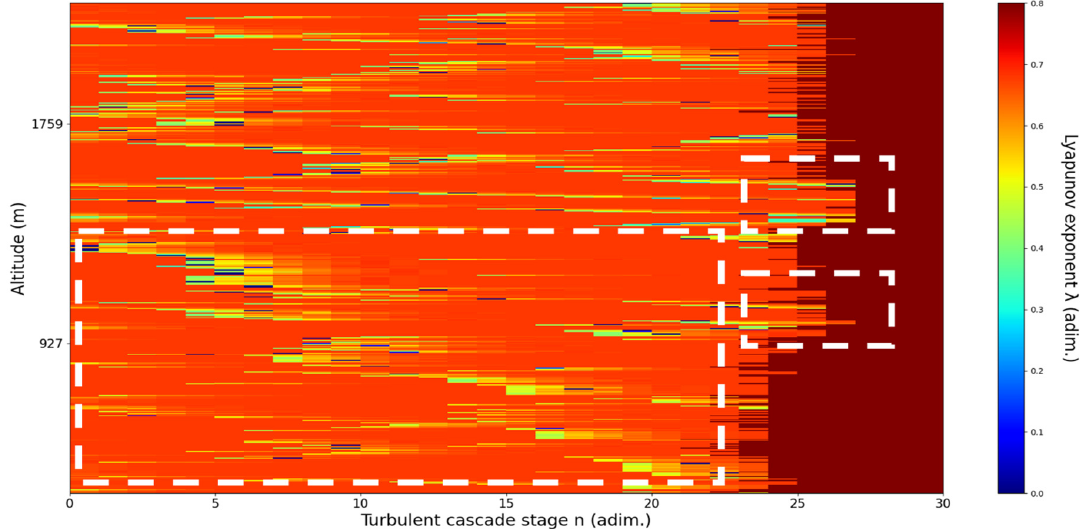
Figure 25. Lyapunov exponent per turbulent cascade stage colormap altitude plot, Bucharest, Romania, 13 June 2019, 07:51:00; point of interest: 1500 m.